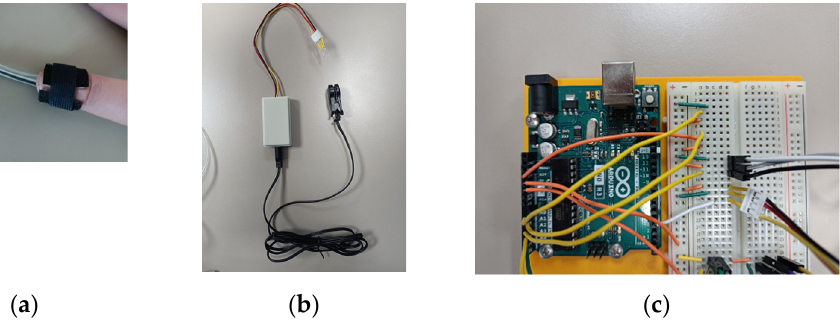
Figure 6. ( a ) The target’s finger with the finger heartbeat sensor tied with Velcro; ( b ) the ear clip heartbeat sensor; ( c ) the Arduino board with the electrical connections. Equipment: Joy-it SEN-KY039HS (Simac Electronics GmbH, D-47506 Neukirchen-Vluyn, Germany) and Seeed Grove-Ear-clip Heart Rate Sensor (Seeed Technology Co., Ltd., Nanshan, Shenzhen, China).